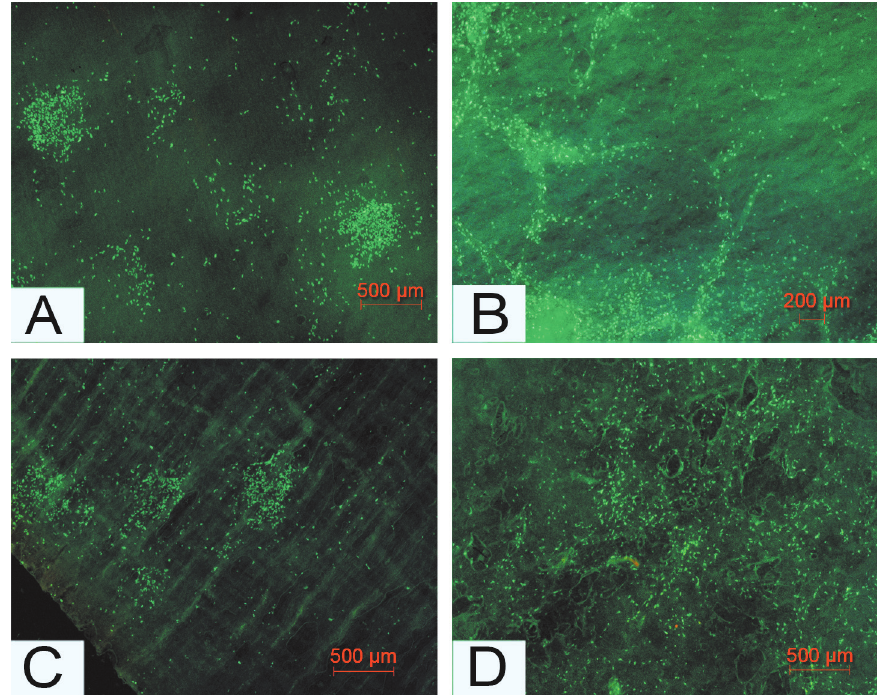
Figure 3- Growth behavior of human gingival fibroblasts on both sides of the two materials. A (BG) and C (MG) show the fluorescent visualization of distribution/growth behavior of the gingival fibroblast on the compact layers of the materials, while B (BG) and D (MG) display the cellular behavior on the spongy layers of the materials. Magnifications: A and C x200; (scale bar=500 µm); B x100 (scale bar=200 µm); and D x200 (scale bar=500